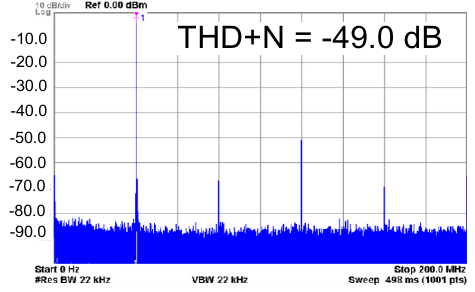
Figure 11. Measured FFT and THD+N of the proposed hybrid line driver at F IN = 40MHz and output swing of 2.8 V PP differential.